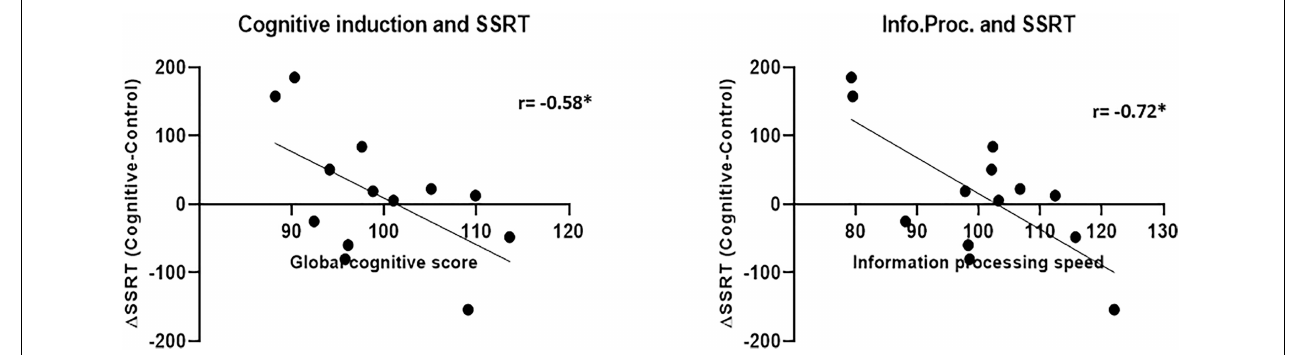
FIGURE 12 | Cognitive induction measures and SSRT between-conditions difference. Better performance in the cognitive induction task, as measured by the global cognitive score (left) , was related to SSRT improvement (representing response inhibition) in the MPH-Cognitive condition compared with the MPH-control condition. This relationship was also found for the information processing speed subscore (right) (* p < 0.05,